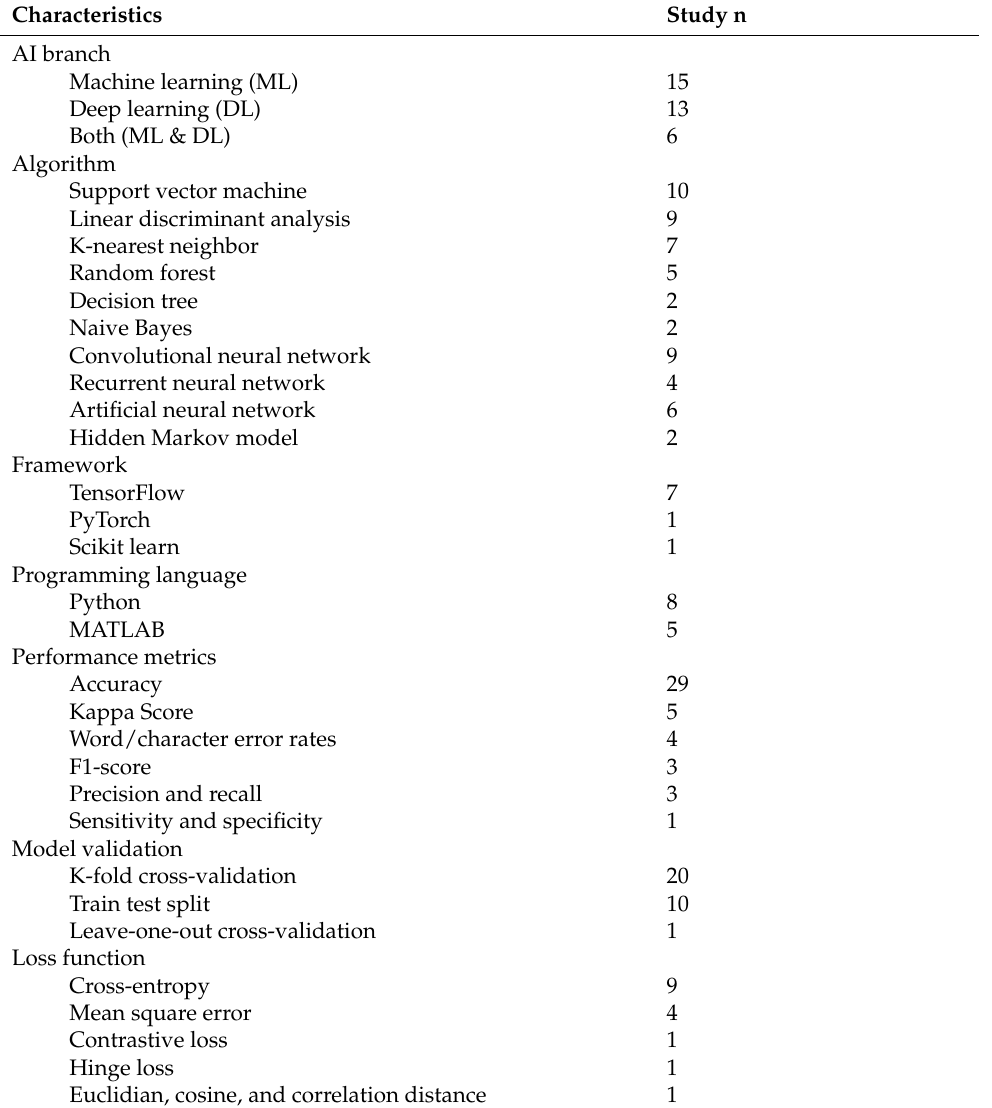
Table 2. Characteristics of AI-based